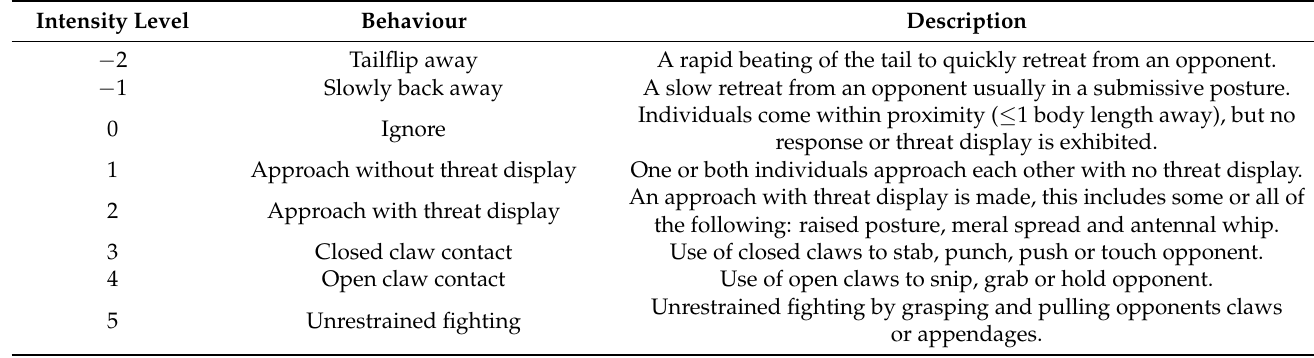
Table 1. Ethogram of aggressive behaviours in crayfish adapted from Bergman & Moore